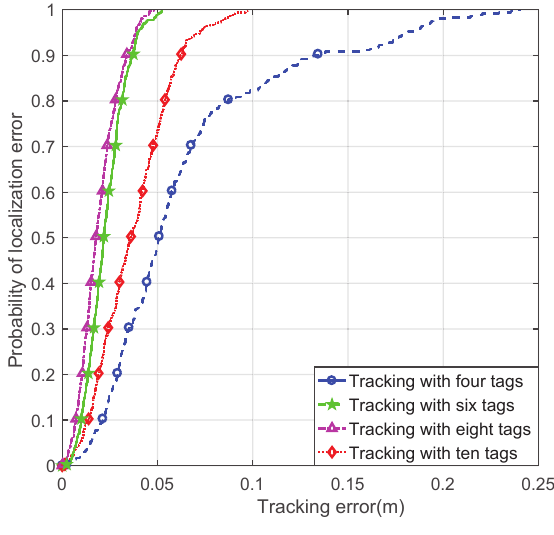
Tracking with four tags Tracking with six tags Tracking with eight tags Tracking with ten tags